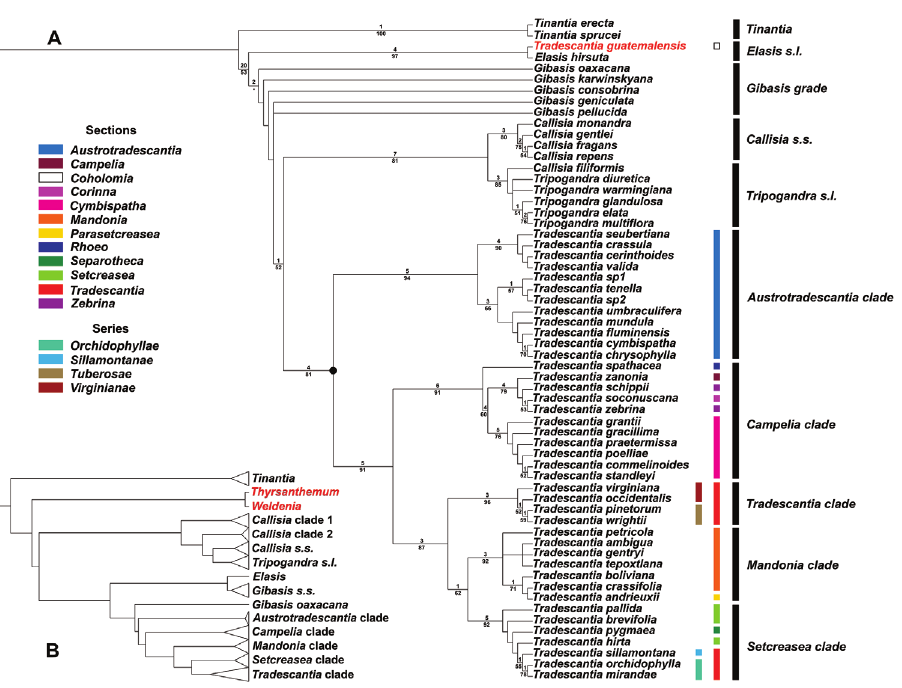
Figure 4. Congruence between morphological and molecular datasets. A, majority-rule tree showing the sections and series proposed by Hunt (1975, 1980, 1986b) color-coded; the five newly proposed subgen- era are represented by the black bars; Tradescantia guatemalensis C.B.Clarke ex Donn.Sm. is depicted in red, to highlight its placement as sister to Elasis hirsuta (Kunth) D.R.Hunt; the ● represents Tradescantia s.s. ; Bremer Index support values are depicted over the branches, while bootstrap support values are de- picted under the branches B simplification of the current hypothesis for phylogenetic relationships in tribe Tradescantieae, based on molecular data. Thyrsanthemum Pichon and Weldenia Schult.f. are depicted in red since they were not sampled in the present study. Modified from Hertweck and Pires